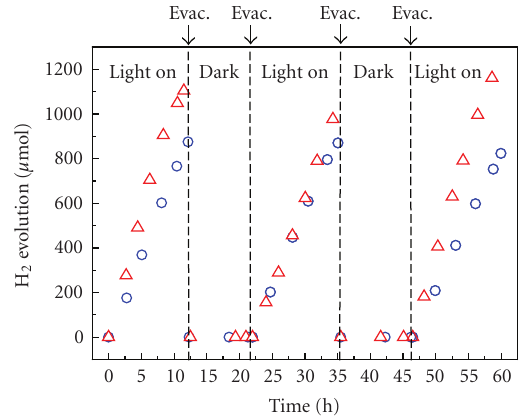
Figure 6: Photocatalytic H 2 evolution from the aqueous methanol solution (50 ml CH 3 OH, 350 ml H 2 O) dispersed with the 0.5 wt% Pt-loaded La 1 / 3 MO 3 (M = Nb, Ta) powder samples (0.5 g) under UV light irradiation. Light source: a 400 W high-pressure Hg lamp (cid:2) : La ◦ : La 1 / 3 NbO 3 ; 1 / 3 TaO 3 .